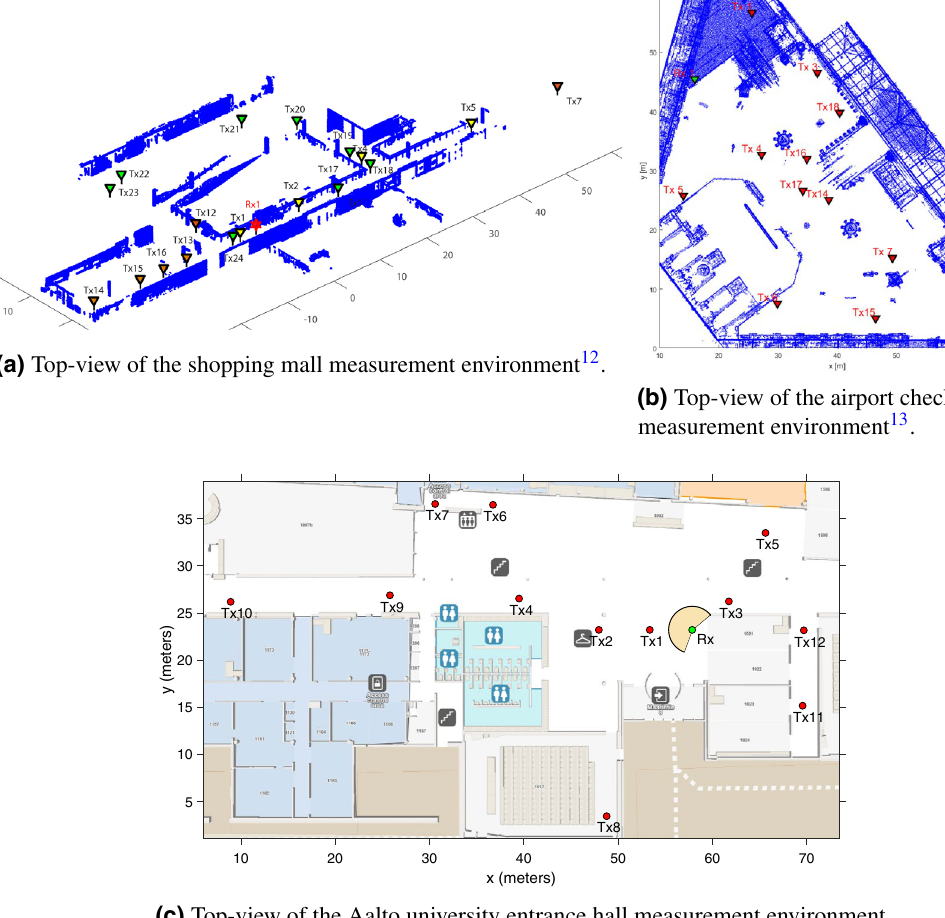
Figure 1. Measurement